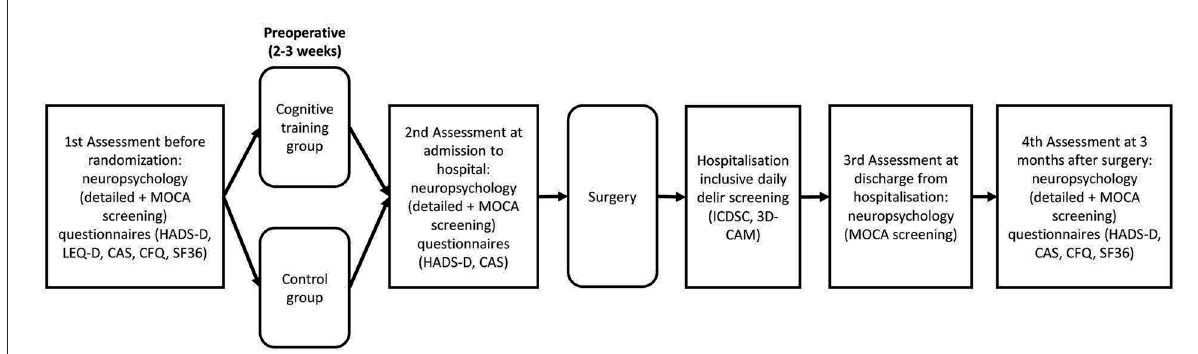
FIGURE1 Timeline of the study-related events. The first examination includes neuropsychological tests and questionnaires before randomization and training. After the preoperative training period, neuropsychological tests and questionnaires will be administered a second time on admission to the acute clinic. After the surgery, daily delirium screenings will be performed and, on discharge from the acute clinic, neuropsychological screening will be carried out. To determine the long-term effects of cognitive training, neuropsychological tests and questionnaires will be carried out 3 months after surgery. MOCA, Montreal Cognitive Assessment; HADS, Hospital Depression and Anxiety Scale; LEQ-D, Lifetime of Experiences Questionnaire; CAS, Cognitive Activity Scale; CFQ, Cognitive Failure Questionnaire; SF-36, 36-Item Short Form Health Survey; ICDSC; Intensive Care Delirium Screening Checklist; CAM, Confusion Assessment Method.